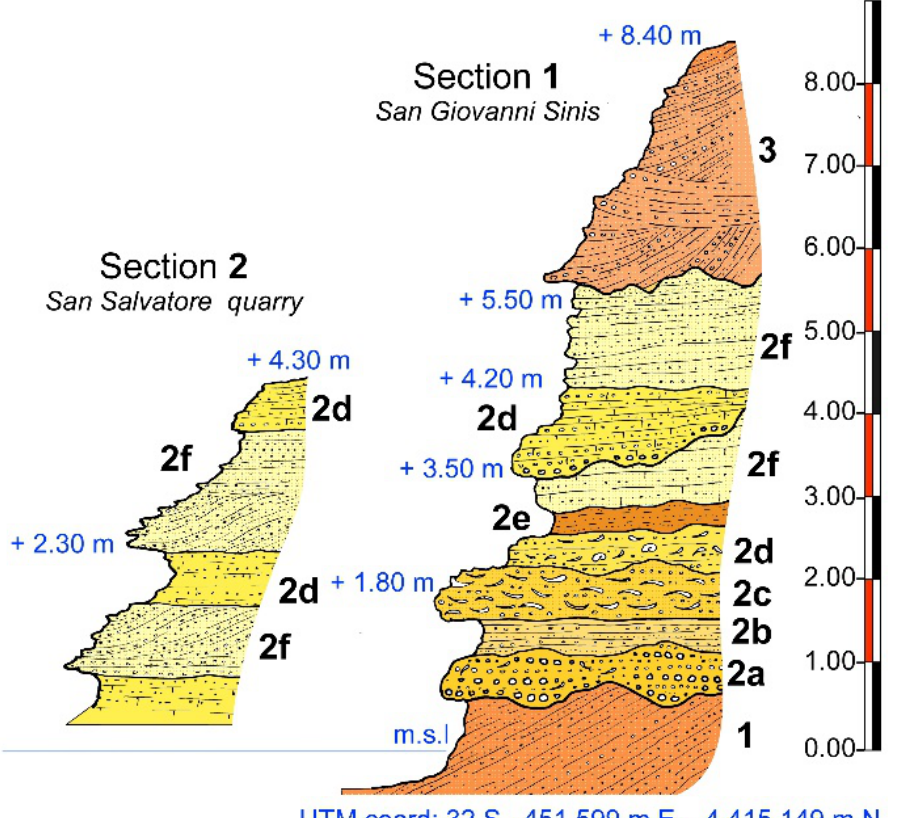
Figure 7. Stratigraphic sections of the medium-upper Pleistocene sequences in Oristano’s north coastal plain and in the Sinis peninsula. (1) (Section 1): eolian sandstones with inclined layering laminae containing vertebrate remains (MIS6); (2a): polygenic heterometric conglomerate with a fossiliferous arenaceous matrix (MIS5); (2b): sandstones and micro-conglomerates mainly quartz with carbonate cement (MIS5); (2c): almost exclusively organogenic level in Mitilus galloprovincialis (MIS5); (2d): fossiliferous conglomerate and micro-conglomerates with a well-cemented arenaceous matrix (MIS 5); (2e): sandy palaeo-soil with a strongly oxidized matrix, Munsell 5YRS 5/8; (2f): planar-parallel lamination sandstones alternating with foreset levels (MIS5); (3): cross-laminated aeolian sandstones containing foraminifera and gastropods pulmonata Helicidae (MIS 4?) [36,37].